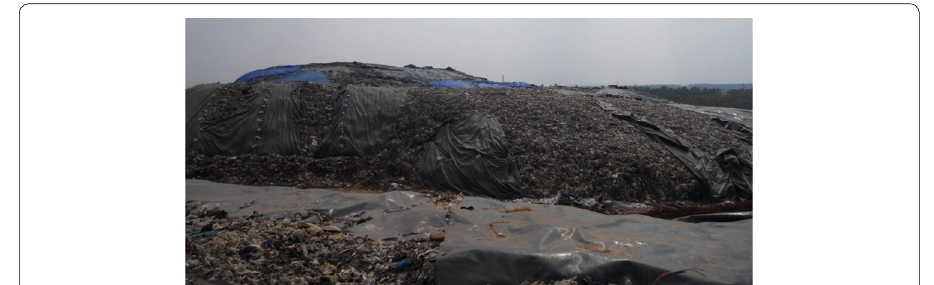
Fig. 2 Scenario of municipal solid waste in Mavallipura